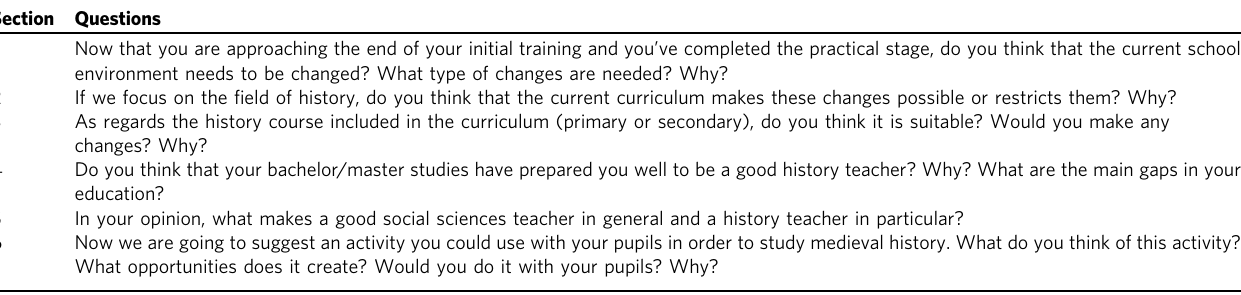
Table 3 Discussion group